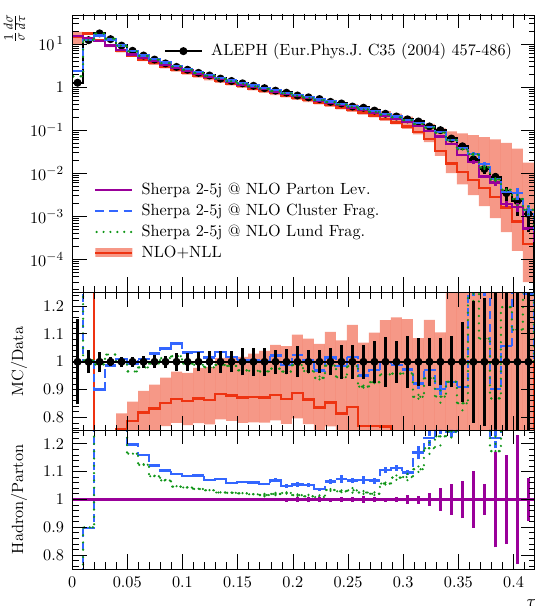
Figure 2. Plain thrust distribution as measured by ALEPH compared to Sherpa at parton level and with cluster and Lund fragmentation, and compared to the nominal resummed distribution matched to NLO. The lower panel shows the hadronisation corrections as obtained from Sherpa with the two fragmentation models considering MEPS@NLO with up to 5 jets at